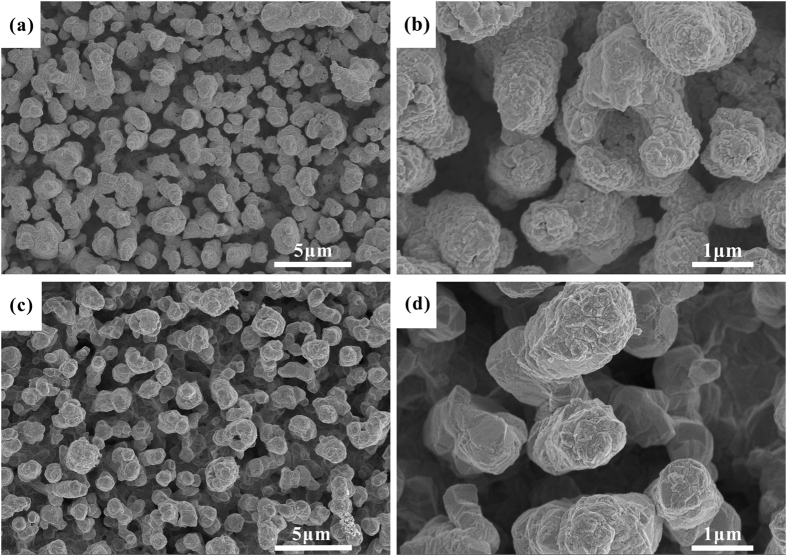
SEM images of Ag/TiO2/Au coatings (a) and Ag/Au coatings (c,b and d) are high magnification of (a and c).